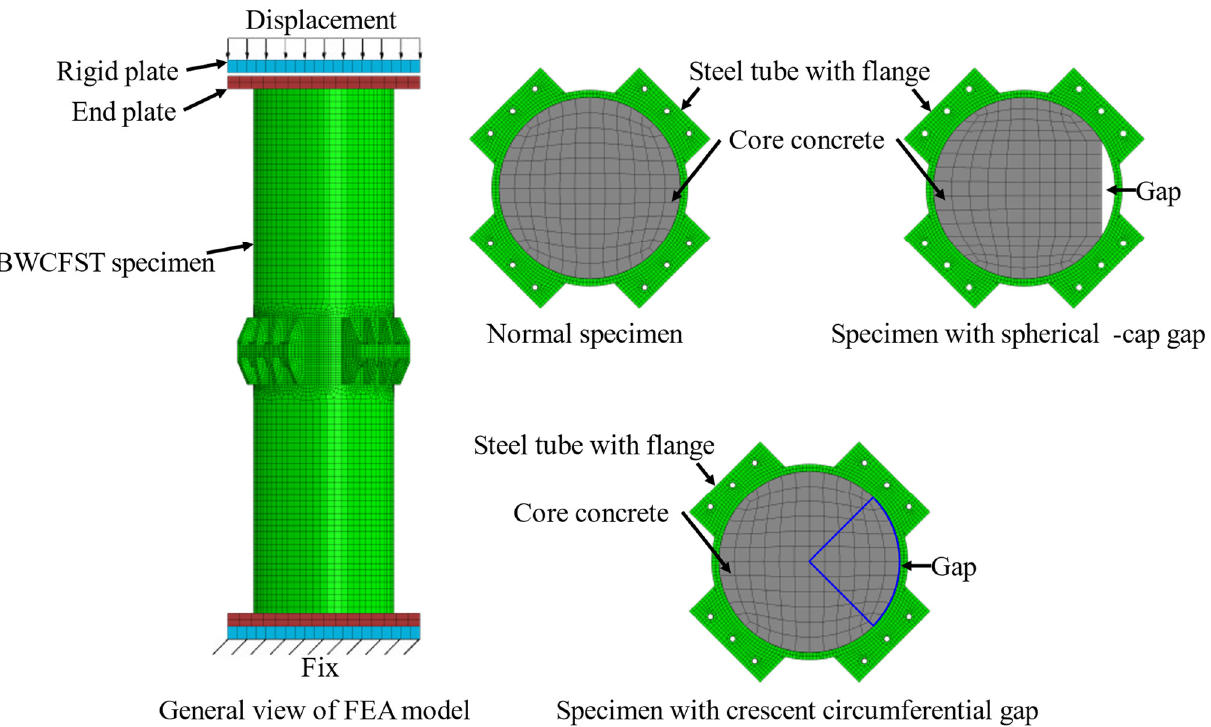
Figure 18. FEA model for BWCFST.